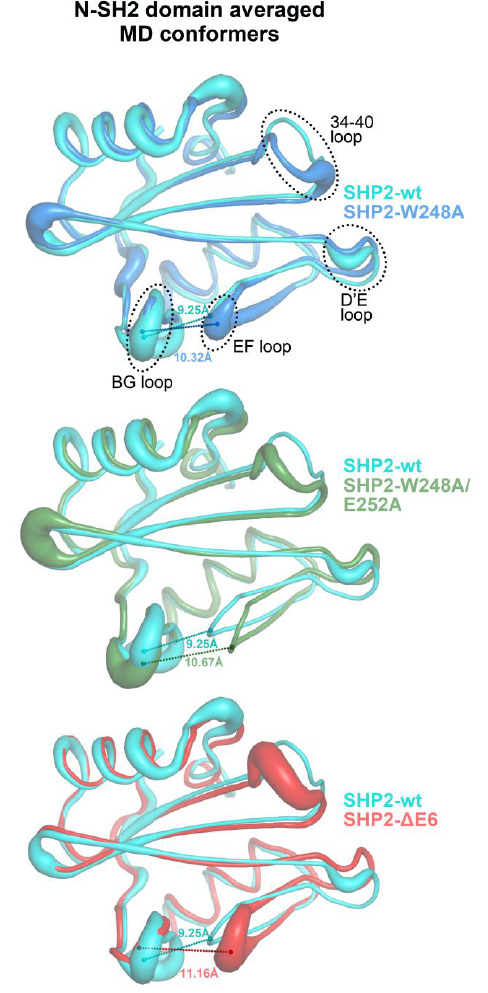
Figure 6. Averaged MD conformers of the N-SH2 domain from the simulations of the self-inhibited SHP2 and its mutants with weakened or annulled interactions between E6 and N-SH2 (averages were made on the conformers, collected every 5000 femtoseconds in the 3–30-ns time interval and previously aligned across N-SH2 domain residues 3–103 to the structures kickstarting the respective MD simulations). A larger ribbon thickness indicates a higher RMSD (calculated at C α atoms). For the sake of clarity, pairwise structural superpositions between the wild-type SHP2-wt protein and each mutant (SHP2-W248A, SHP2-W248A/E252A, and SHP2- ∆ E6) are presented. The distance between the EF and BG loops (measured between the C α atoms of Gly67 and Asn92) is labeled on each averaged